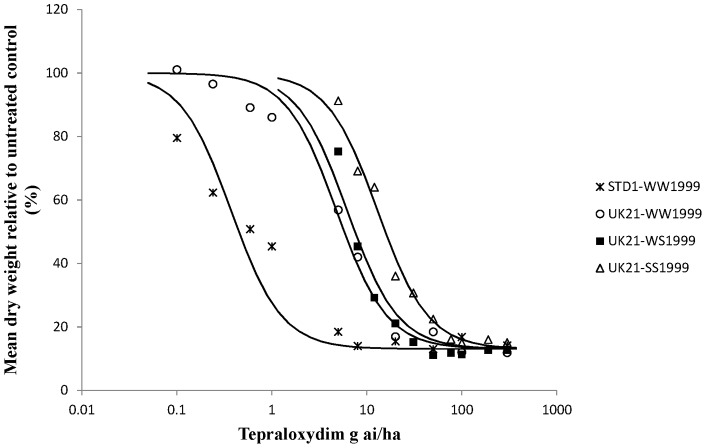
Tepraloxydim dose response tests on four plant groups: homozygous wild type WW1999, heterozygous WS1999 and homozygous mutant SS1999 from the mixed resistant population UK21 and standard sensitive STD1 plants (WW1999) for comparison.Observed values represent dry weight relative to untreated (%) averaged across mother plants. The curves are constructed based on the average GR50 across biological and technical replicates.